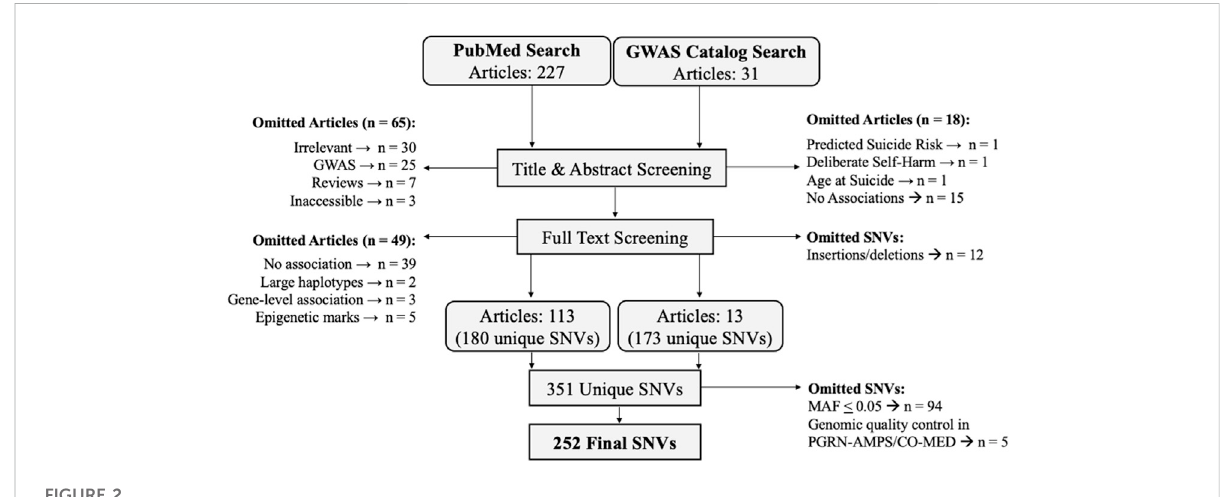
FIGURE 2 Single nucleotide variation (SNV) search